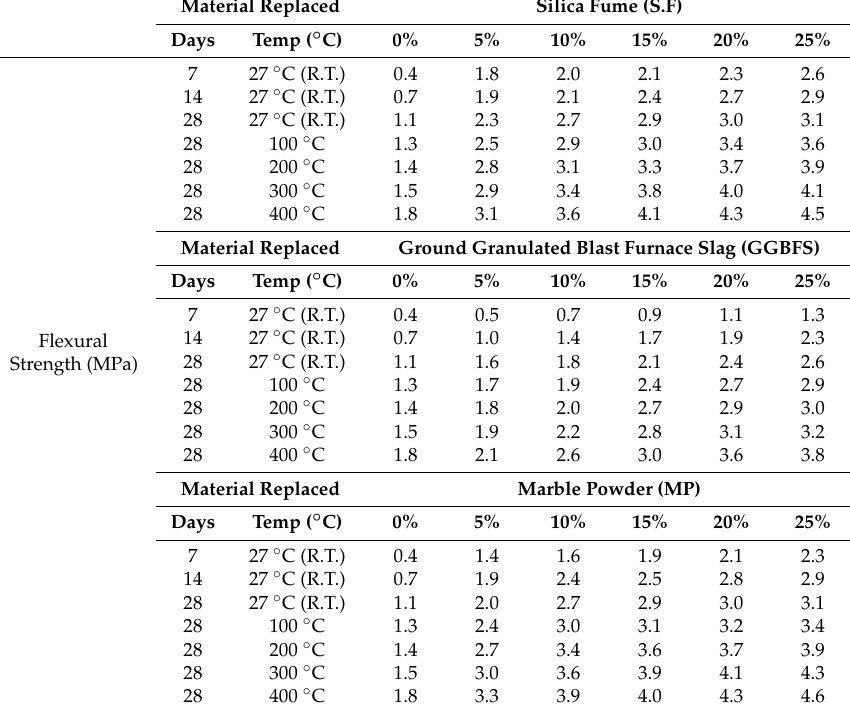
Table 6. Test results for hardened self-compacted concrete (flexural strength,